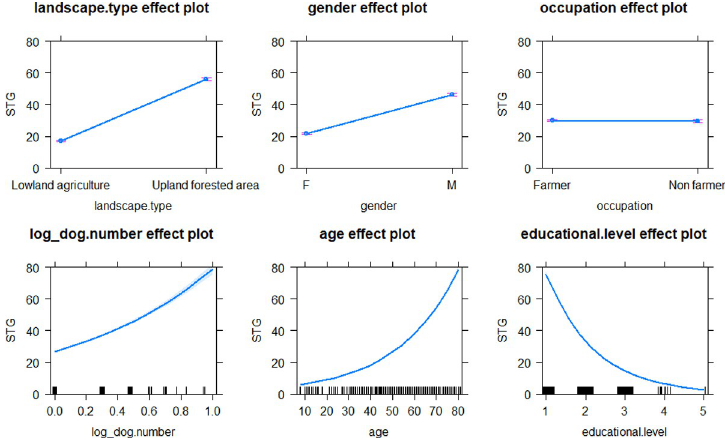
Fig 3. Effect plots of explicative variables after best model fitting with GLM to estimate level of STG exposures in inhabitants of Saen Thong Subdistrict, Nan Province. Marks on the X-axis represent individual observations.